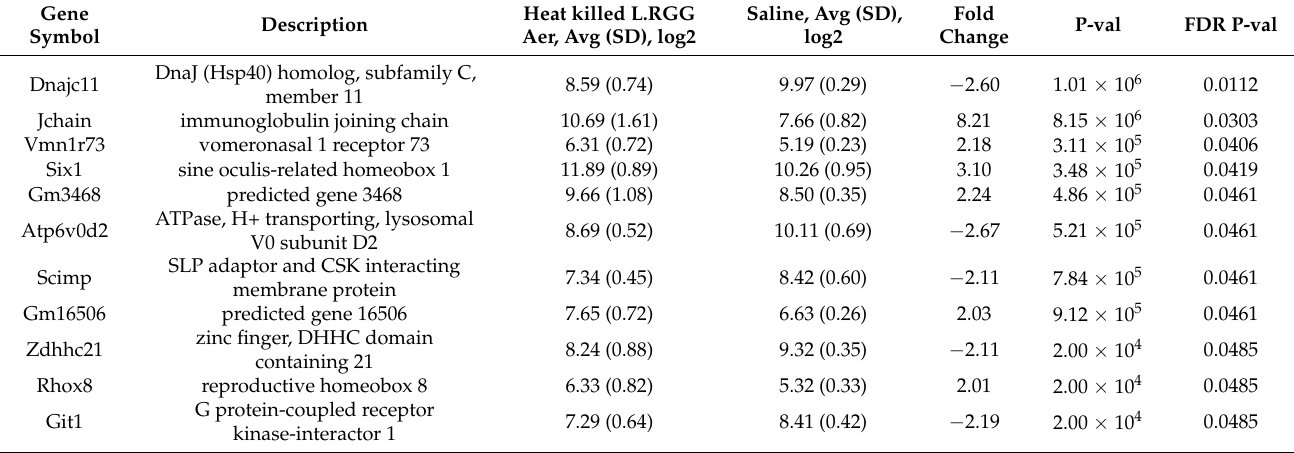
Table 1. Effect of dead L.RGG aerosol treatment on transcriptomic profile of the lung. Genes differentially expressed in comprehensive gene expression profiles comparing RNA extracted from heat-killed L.RGG -treated lungs versus saline-treated lungs. Gene expression average per group was calculated using one-step Tukey’s bi-weight algorithm, reported as binary logarithm (log2). The fold-change can be calculated as two power of the absolute difference between group averages. A negative fold-change indicates a greater expression in the control group. Further details on the calculations are available on pages 11–12 of the Affymetrix Statistical Algorithms Description Document, http://tools.thermofisher.com/content/sfs/brochures/sadd_whitepaper.pdf (accessed on 15 June 2022) ((FDR p -value < 0.05) (8/9 samples/group). Abbreviations: Avg, average; SD, standard deviation; FDR, false discovery rate.